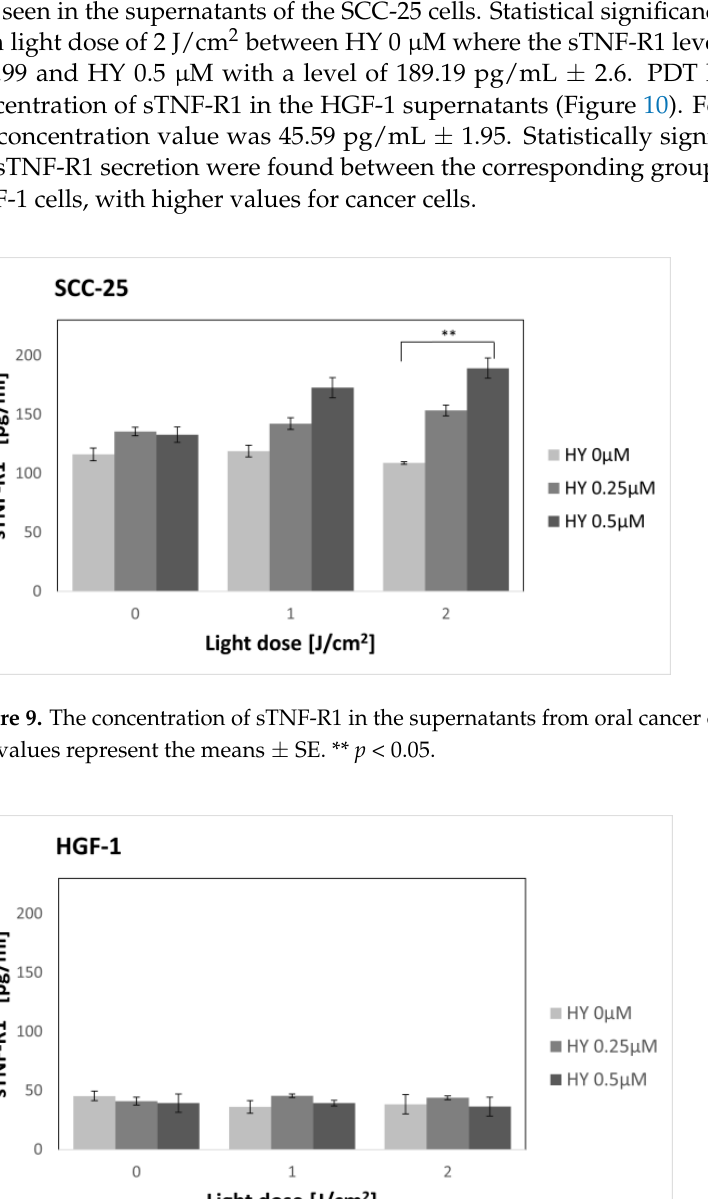
Figure 8. MTT reduction in the SCC-25 and HGF-1 lines for different HY concentrations: 0 µM, 0.25 µM, 0.5 µM, and 1 µM and light dose 20 J/cm 2 . The values represent the means ± SE. *** p < 0.01.